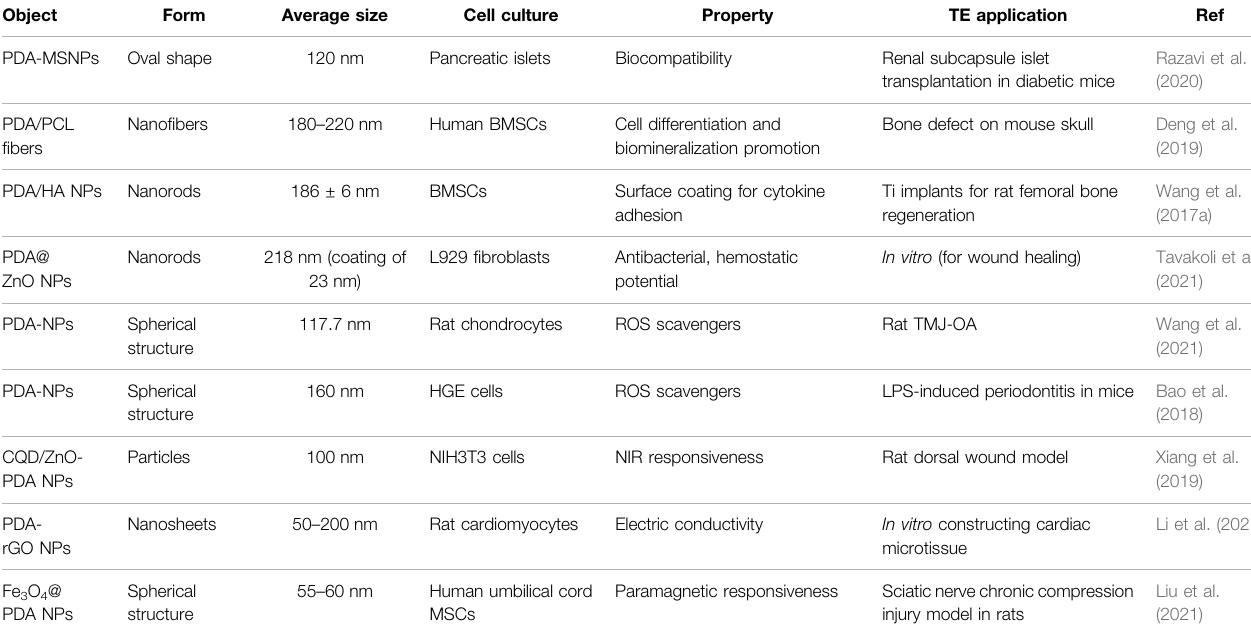
TABLE 2 | Examples for PDA-NPs application in